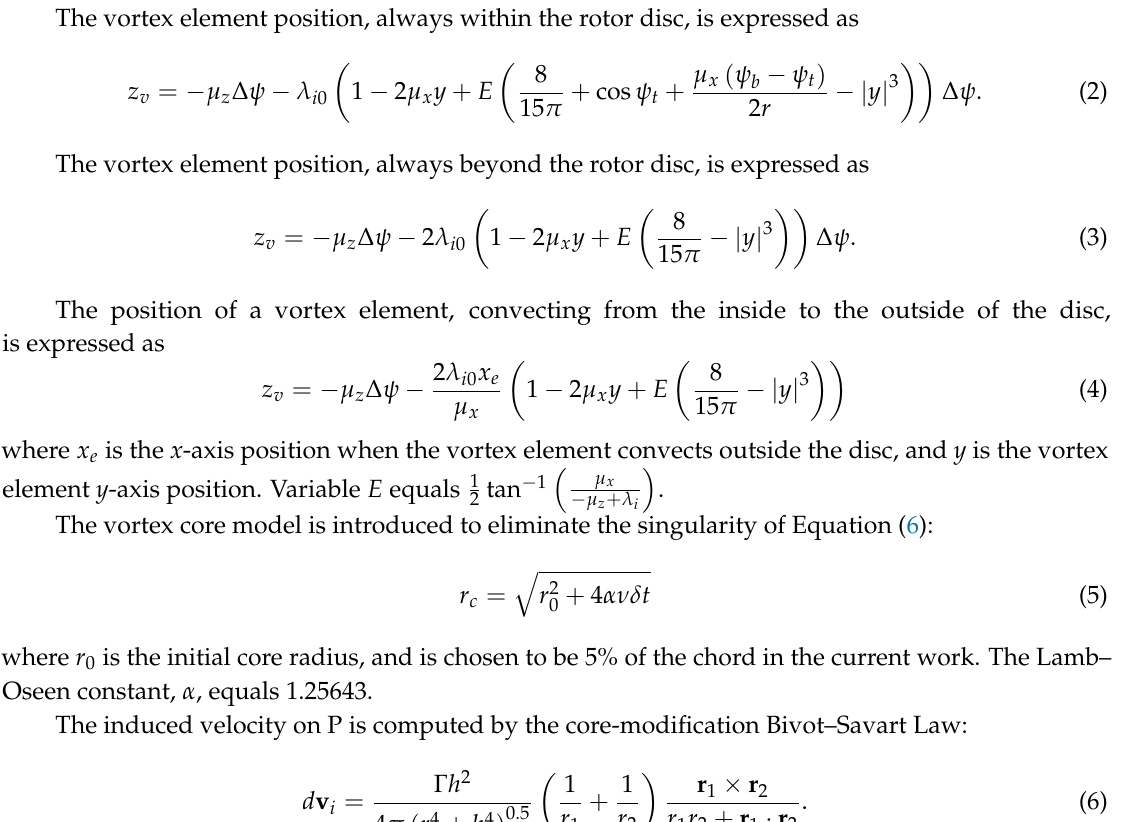
(b) Blade-vortex interaction. Figure 1. Rotor wake